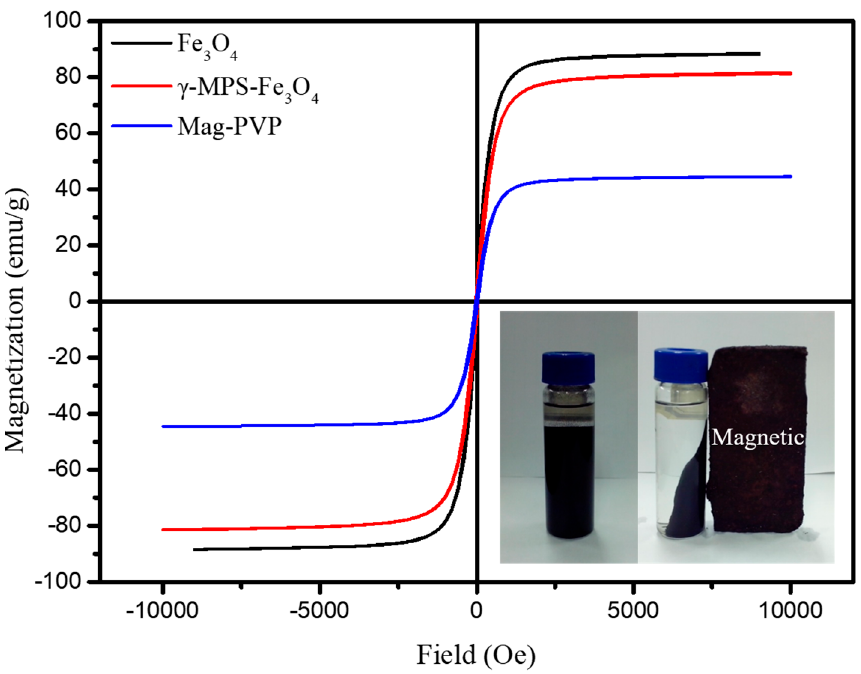
Figure 3. Magnetic hysteresis curves of Fe 3 O 4 , γ -MPS-Fe 3 O 4 , and Mag-PVP.